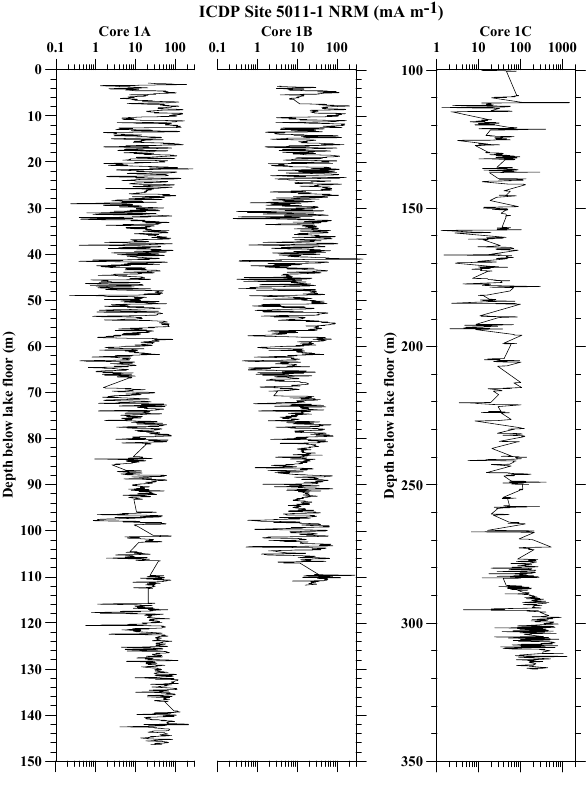
Fig. 2. Down-core variations in the intensity of the natural remanent magnetization (NRM) in cores 1A, 1B and 1C. Note the different scaling in